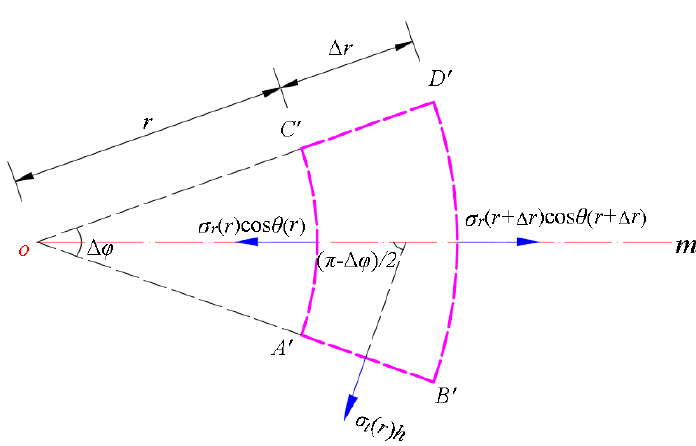
Figure A1. Diagram of the cylindrical coordinate system and the differential element ABCD .